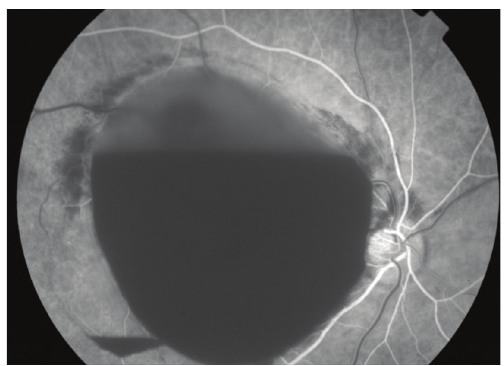
Figure 2: Fluorescein angiography demonstrated hypofluorescence and no evidence of any other pathology.